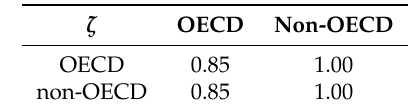
Table A2. Parameter calibration for spillover parameter: ζ